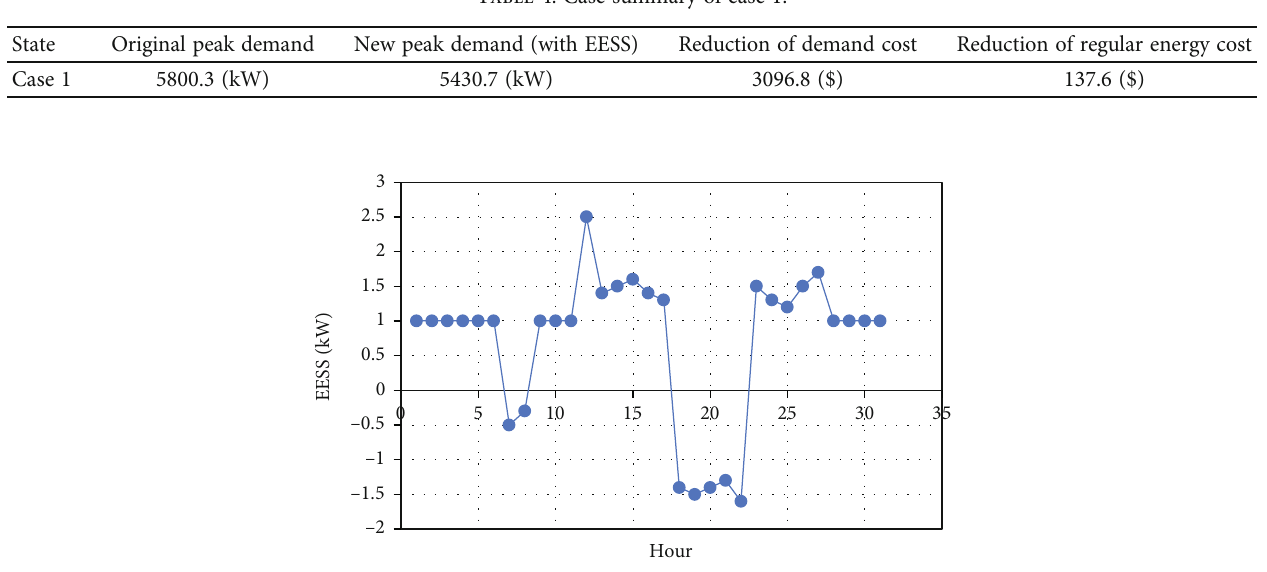
Figure 7: Power of